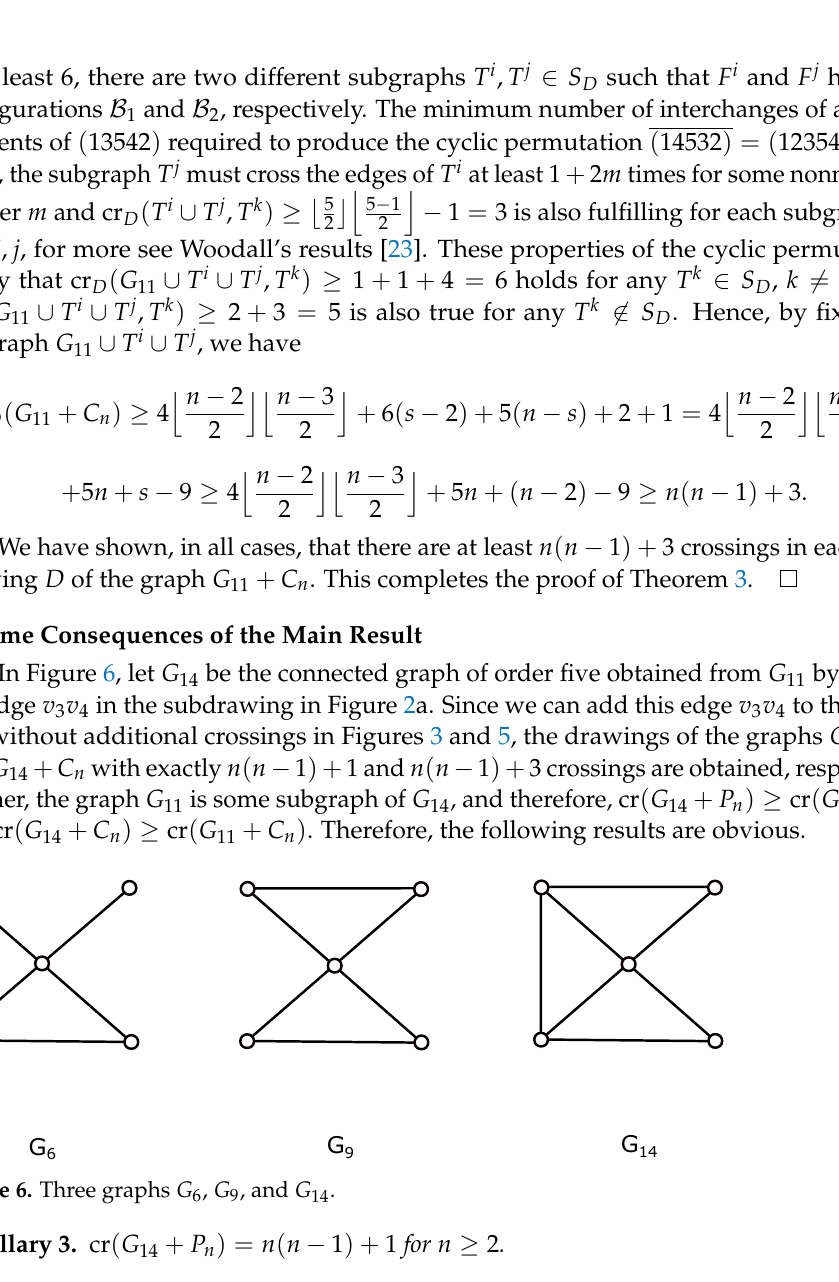
Figure 6. Three graphs G 6 , G 9 , and G 14